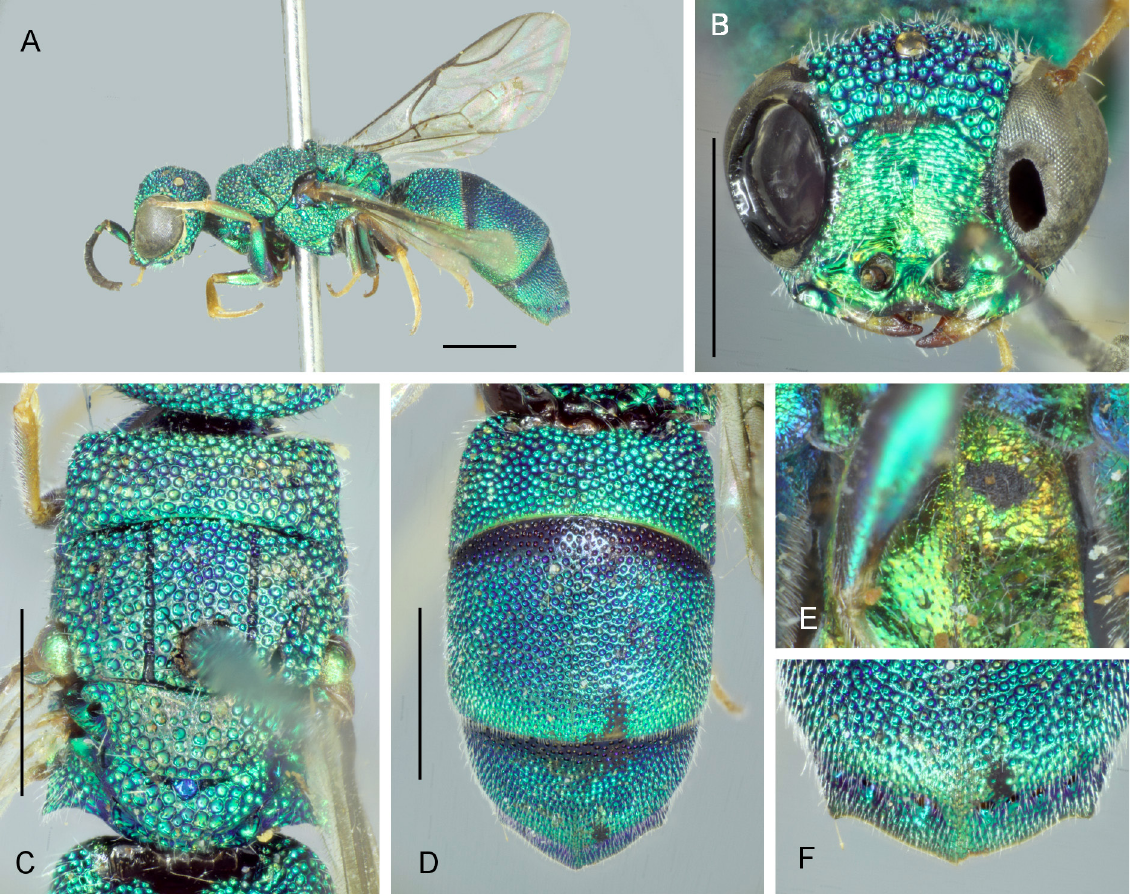
Fig. 6. Chrysidea phoebe Zimmermann, 1956. A–D, F . Holotype, ♀. A . Lateral habitus. B . Head. C . Mesosoma. D . Metasoma. E . Female from Behara, black spots on S2. F . T3. Scale bars = 1.0